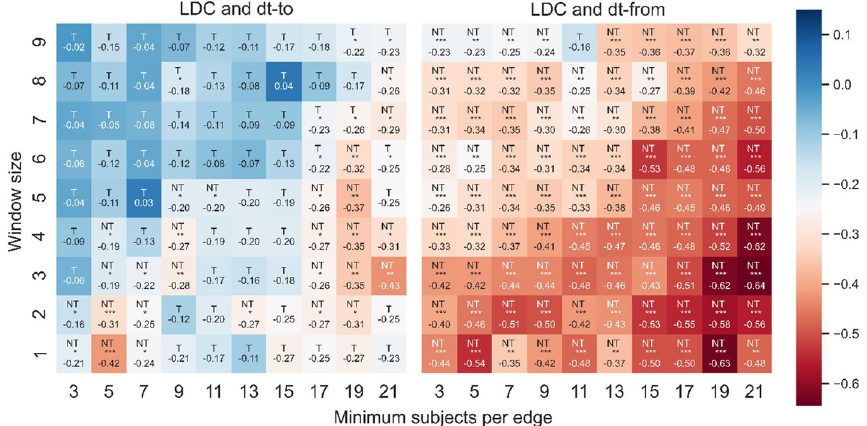
Fig. 9 Triviality test for the correlation between LDC and dt-to and between LDC and dt-from. The color highlights the sign and magnitude of Spearman coefficients. The bluer a cell is, the closer the correlation is to zero. By contrast, red indicates negative values. The number of stars indicates the level of significance. NT/T denotes whether the correlation is